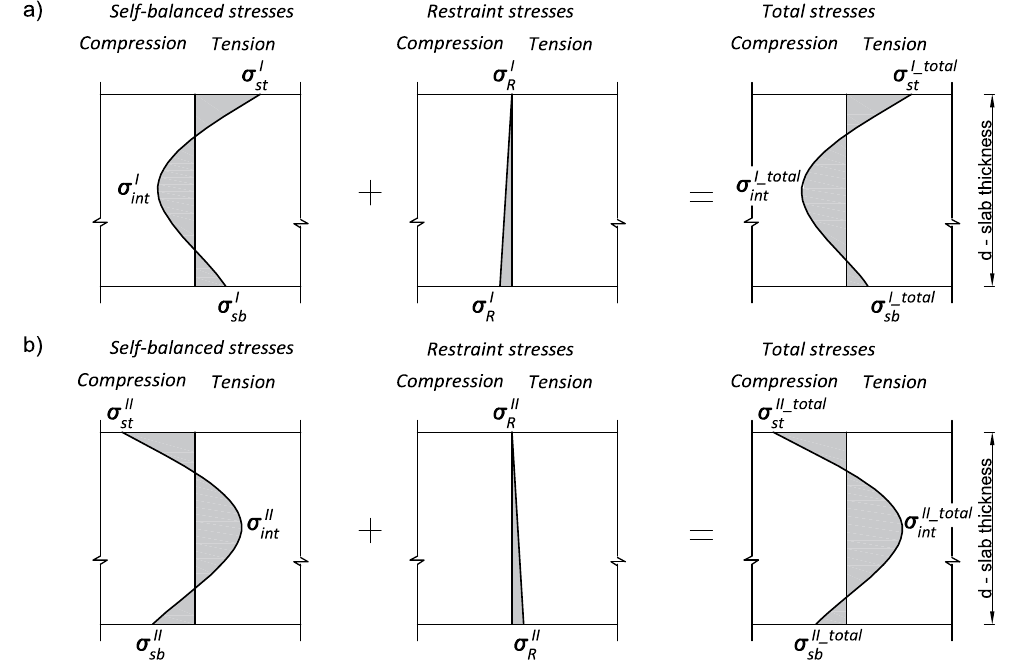
Figure 4. Total thermal stresses at the thickness of the slab: ( a ) Heating phase, ( b ) cooling phase.